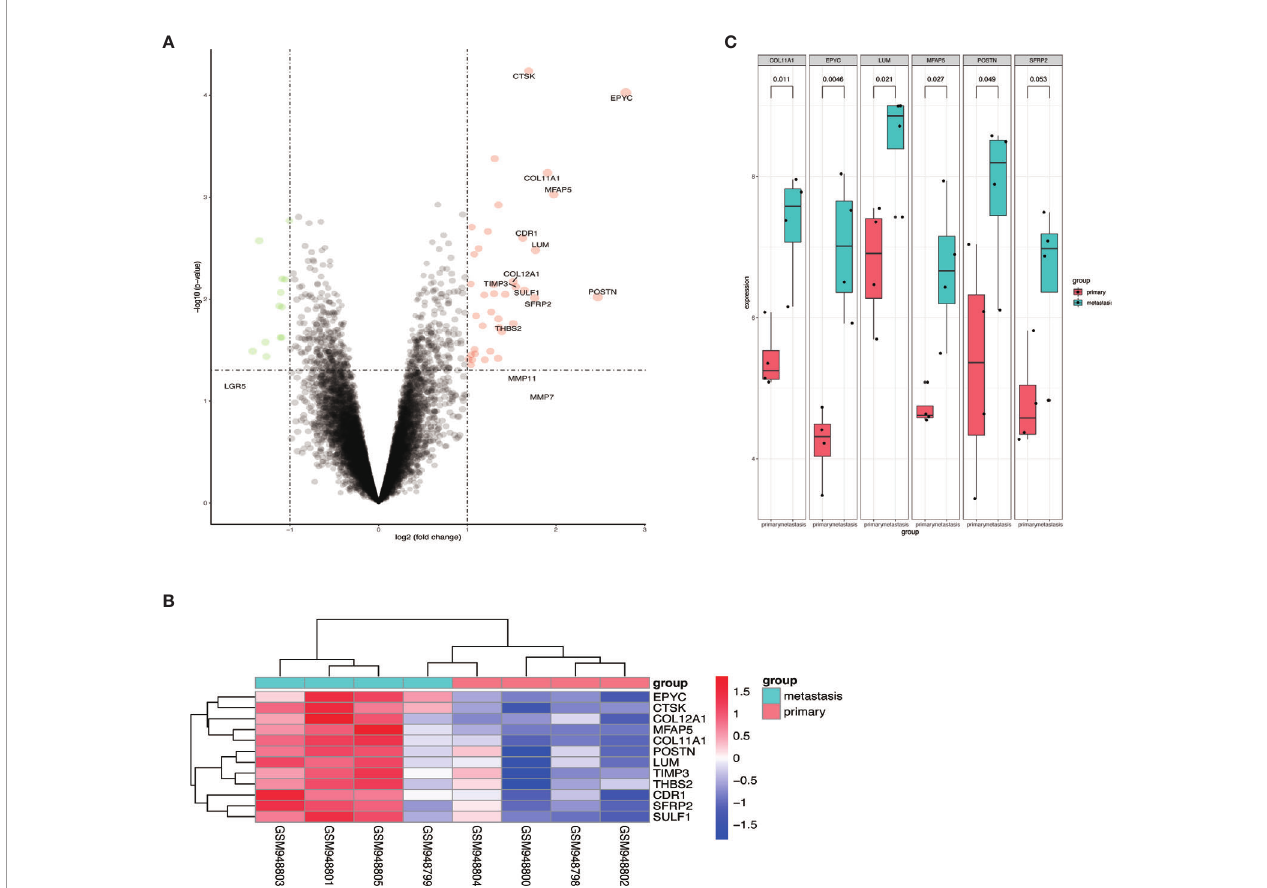
FIGURE 1 | The expression of EPYC in metastatic ovarian cancer tissue was signi fi cantly increased. (A, B) Volcano map and heat map of differential genes from GSE38734 dataset; (C) The top 6 up-regulated genes in ovarian metastatic cancer compared with paired